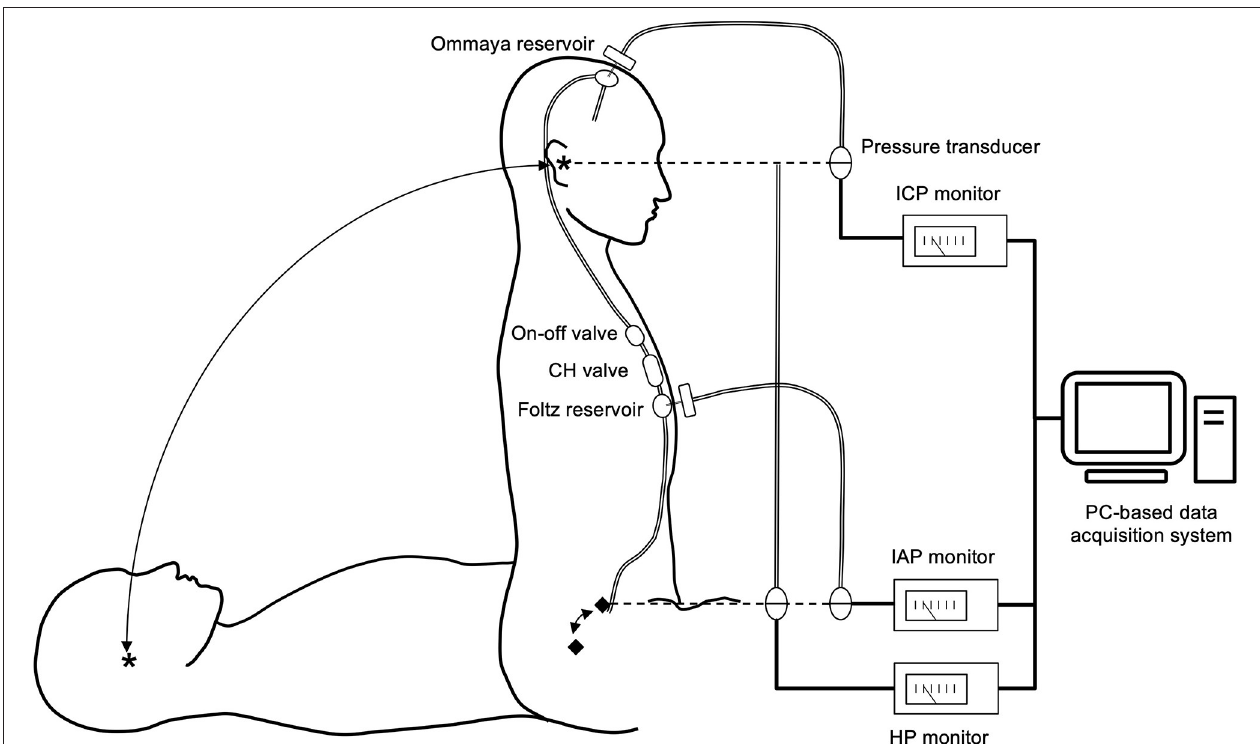
FIGURE 2 | Shunt system and shunt-related pressure measurement system. The patients were implanted with an Ommaya reservoir in the head and an on-off valve, a CH valve, and a Foltz reservoir in the chest. By puncturing both reservoirs with a 22G needle, ICP and IAP can be measured. We defined the reference points for ICP and IAP as the external auditory meatus (*) and the mid-axillary line at the level of the superior anterior iliac crest ( (cid:7) ), respectively. The pressure environment was measured in the supine and sitting positions. We measured the HP of the shunt system as the difference in height between the two reference points. We calculated the shunt PP based on these pressures using the following formula. PP = (ICP–IAP) + HP. Thus, this measurement system provides insight into the comprehensive shunt-related pressure environment. All measurement data were digitized and recorded in a PC-based data acquisition